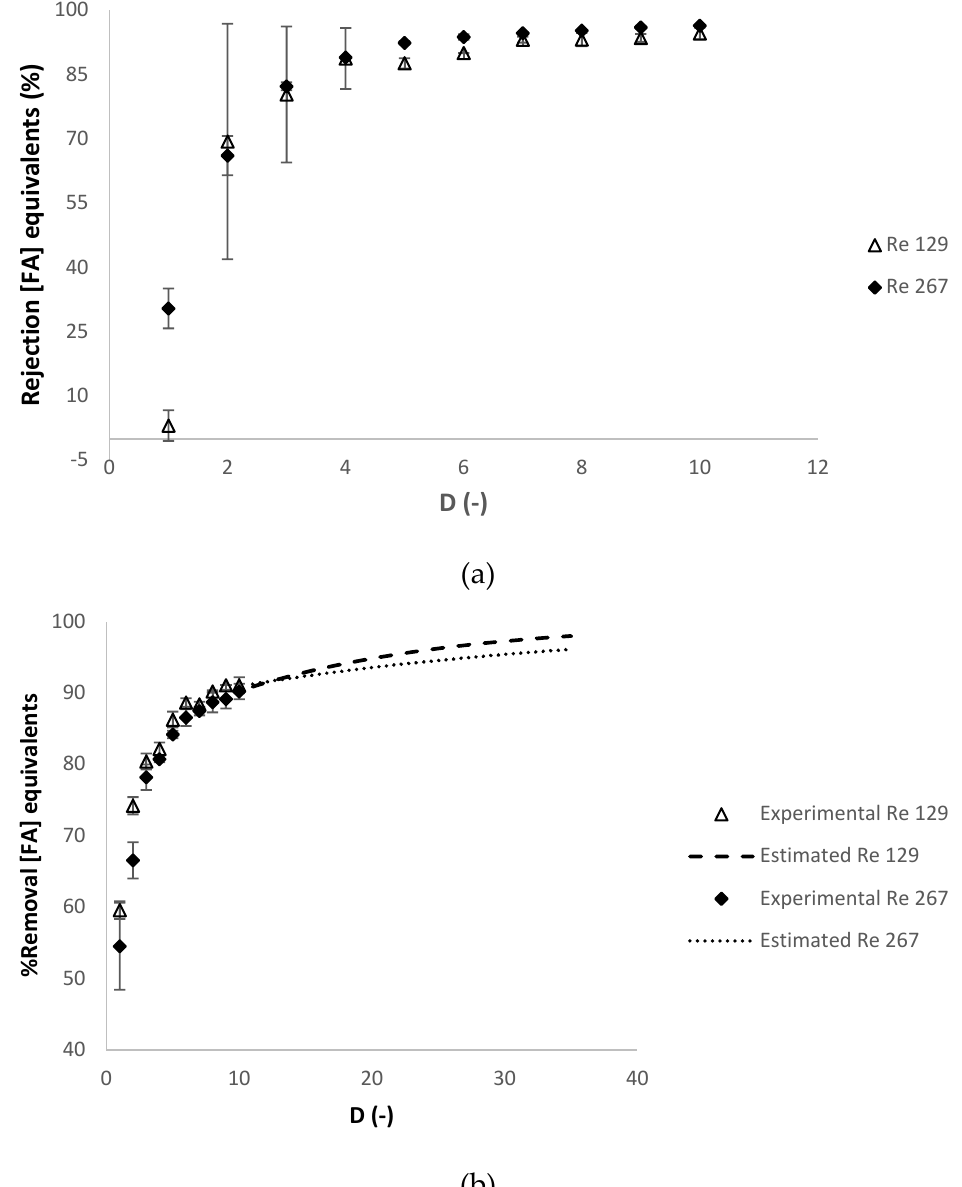
Figure 8. Dia-ultrafiltration at different Reynolds numbers (129 and 267); experiments with (diluted) arabinoxylans fraction as feed, at 40 °C, without relaxation procedure: ( a ) R FA (% FA.eq), apparent rejection in ferulic acid equivalents and ( b ) percentage of removal of charged contaminants in ferulic acid equivalents (FA.eq) against the D (-) diafiltration volume. Each analysis had duplicate measurements.